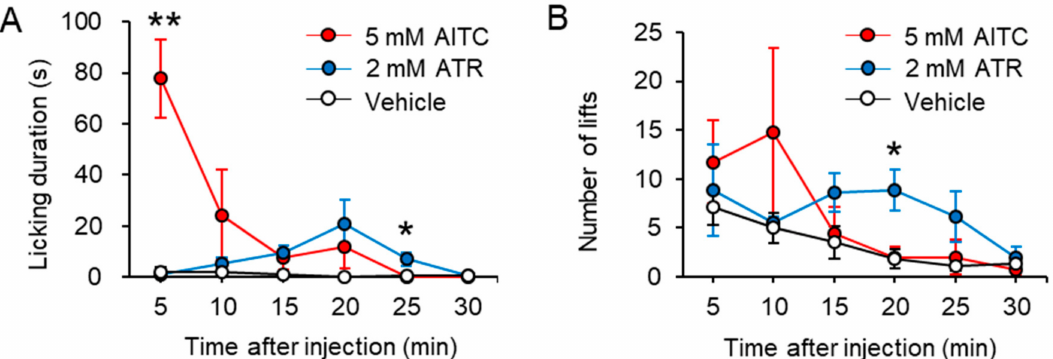
Figure 5. Intraplantar injection of atractylodin induced moderate and prolonged nociceptive behavior in rats. Licking duration ( A ) and number of lifts ( B ) induced by intraplantar injection of 5 mM AITC ( n = 5) and 2 mM ATR ( n = 6) over time (post injection). Data represent mean ± standard error of mean, * p < 0.05, ** p < 0.01 (AITC vs. ATR at the corresponding time point), one-way analysis of variance with the Tukey post hoc test. AITC: allyl isothiocyanate; ATR: